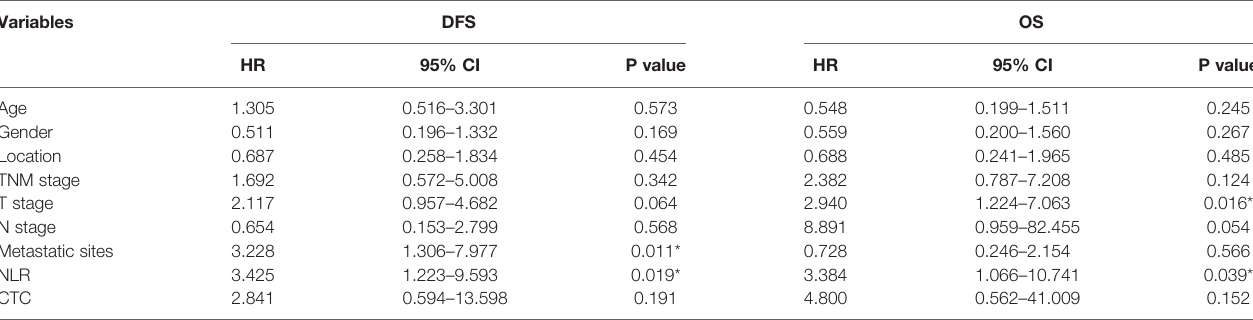
TABLE 4 | Independent factors associated with DFS and OS in multivariate analysis. Variables DFS OS